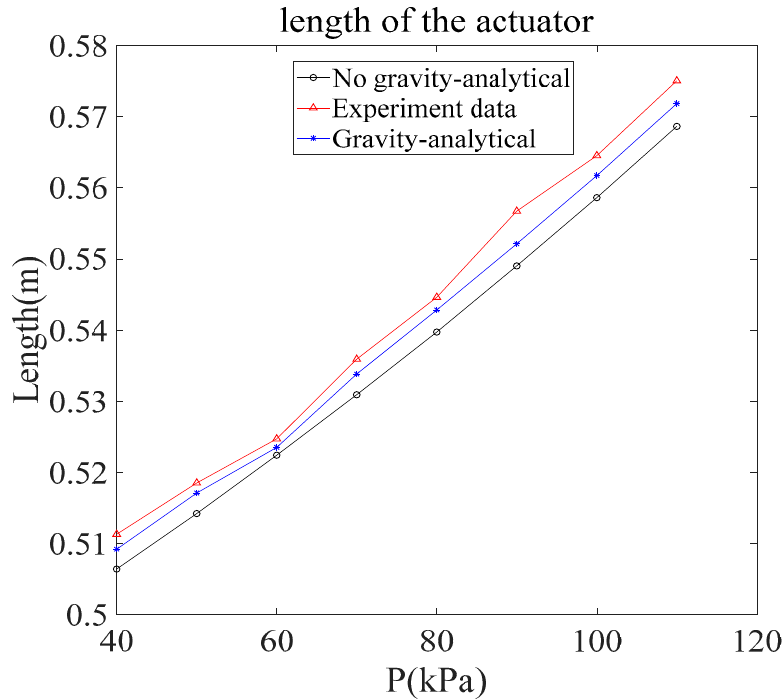
Figure 8. Length of the actuator with the extension module under various pressures (40–110